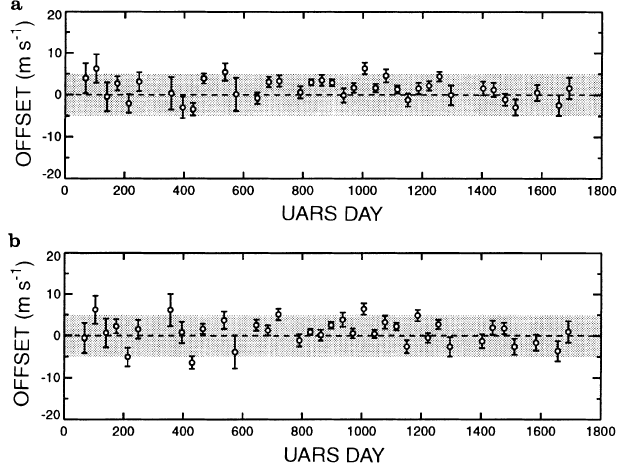
Fig. 4a, b. HRDI zero wind o(cid:128)set determination (cid:133) (cid:101) F (cid:135) (cid:101) B (cid:134) over the mission lifetime a using Eq. 4, and b using Eq. 5. The time-axis is given as UARS day number (days since the launch of the spacecraft on 12 September 1991). The (cid:139)5-m s ) 1 region is shaded gray